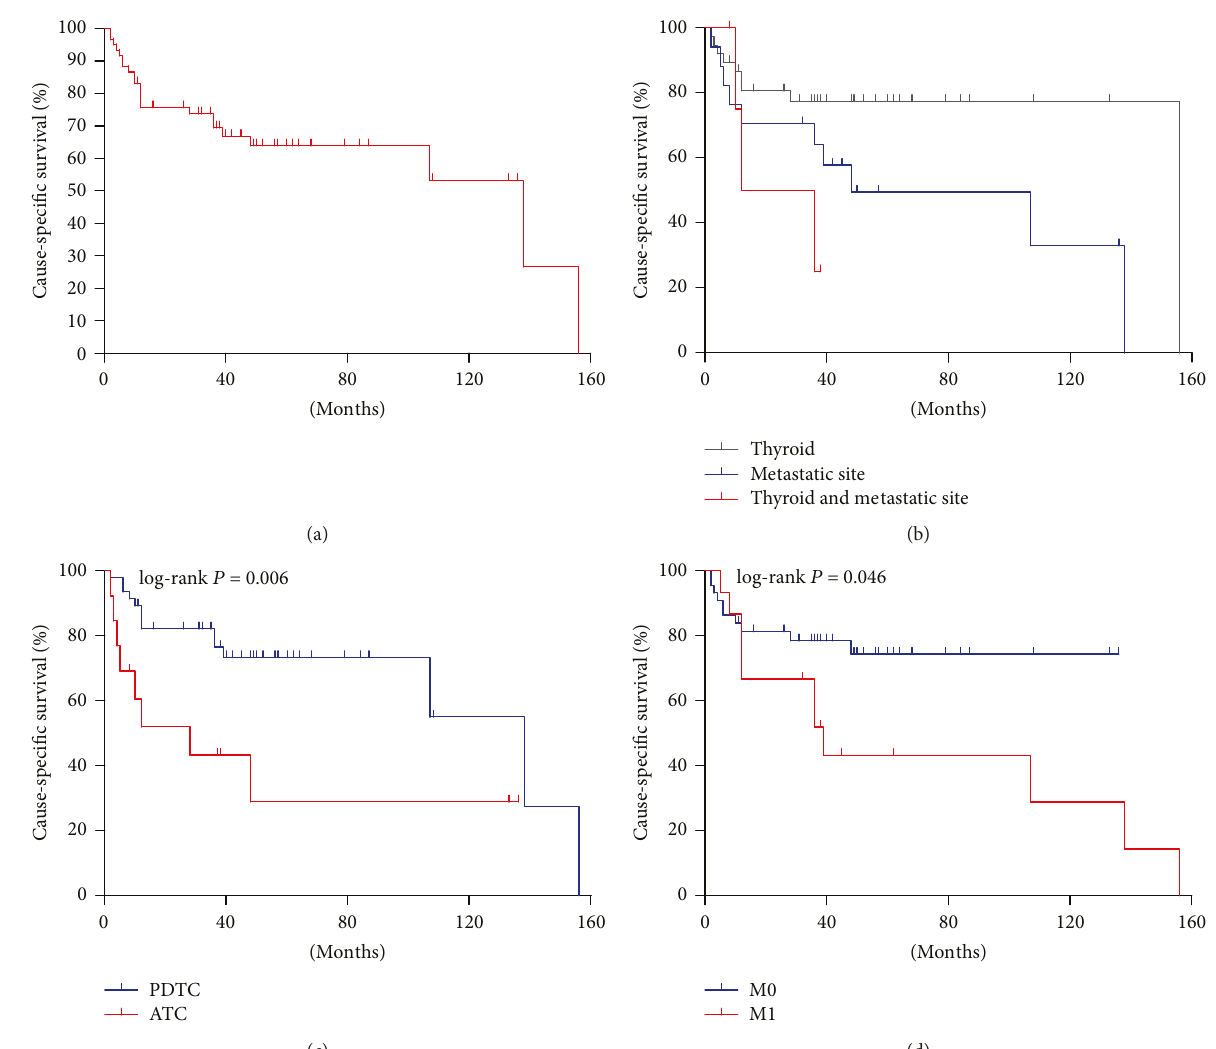
Figure 2: Kaplan-Meier plots of cause-speci fi c survival. (a) The survival plot of all dedi ff erentiated patients. (b) The survival plot grouped by dedi ff erentiated sites indicated a signi fi cant di ff erence between primary dedi ff erentiation in thyroid and metastatic region dedi ff erentiation ( P = 0 04 ). (c, d) The survival plots are shown according to dedi ff erentiated components and distant metastasis (DM),